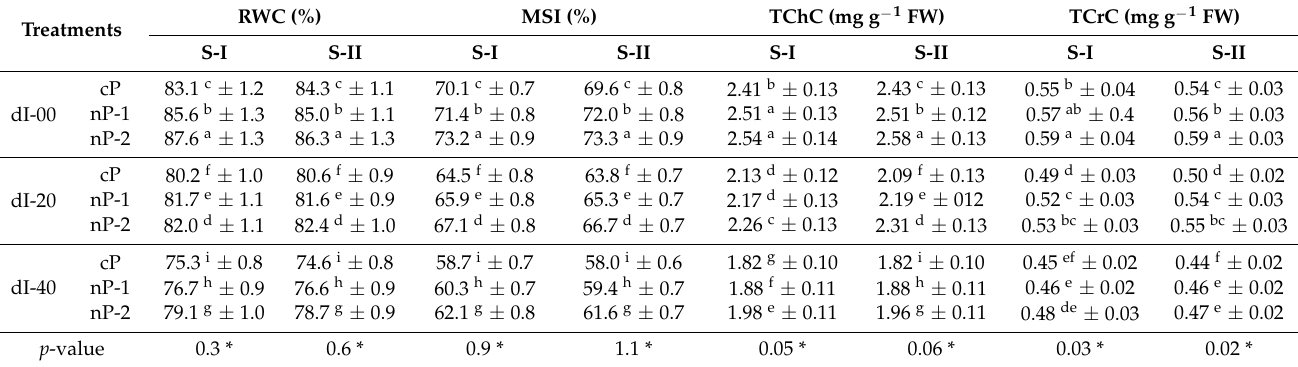
Table 5. Cell integrity and photosynthetic pigment contents of fenugreek plants as affected by different irrigation water regimes and soil and foliar nourishing with phosphorus (P) during two growing